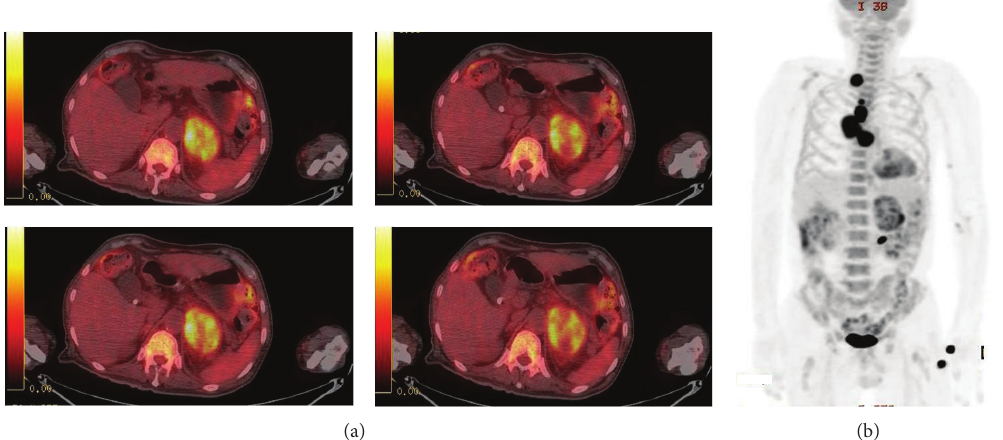
Figure 4: Transaxial image of 18 F FDG PET/CT showed heterogeneously FDG-avid left adrenal gland tumor (a) and MIP of 18 F FDG PET/CT